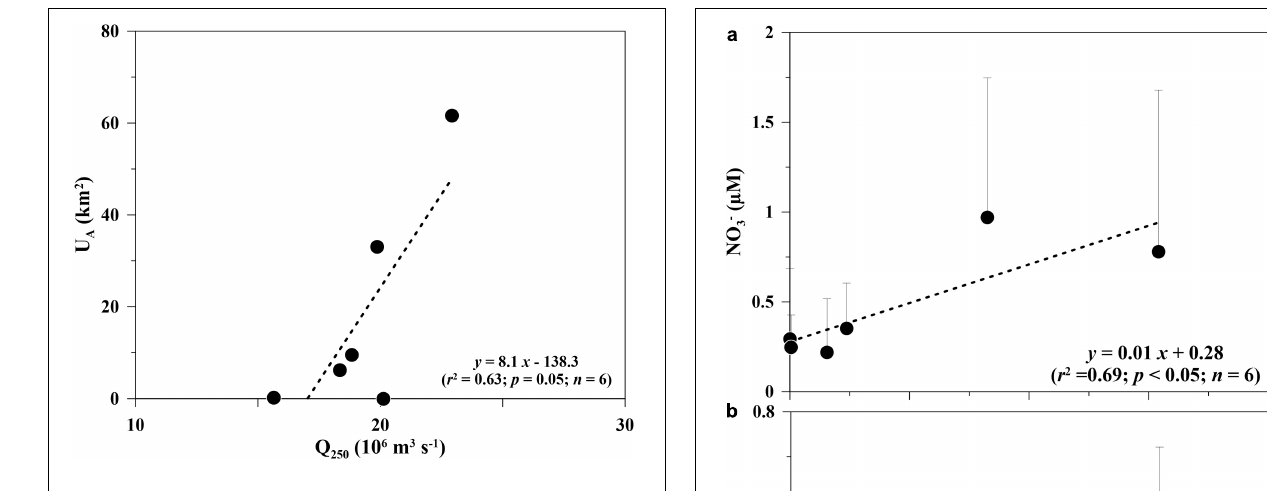
FIGURE 3 | Relationship between the uplift area ( U A ; km 2 ) and volume transport ( Q 250 ; S V ; 10 6 m 3 s − 1 ) at different sampling periods. The slope and r 2 of the linear regression (dashed lines) are shown and also applied to Figures 4 – 6 .